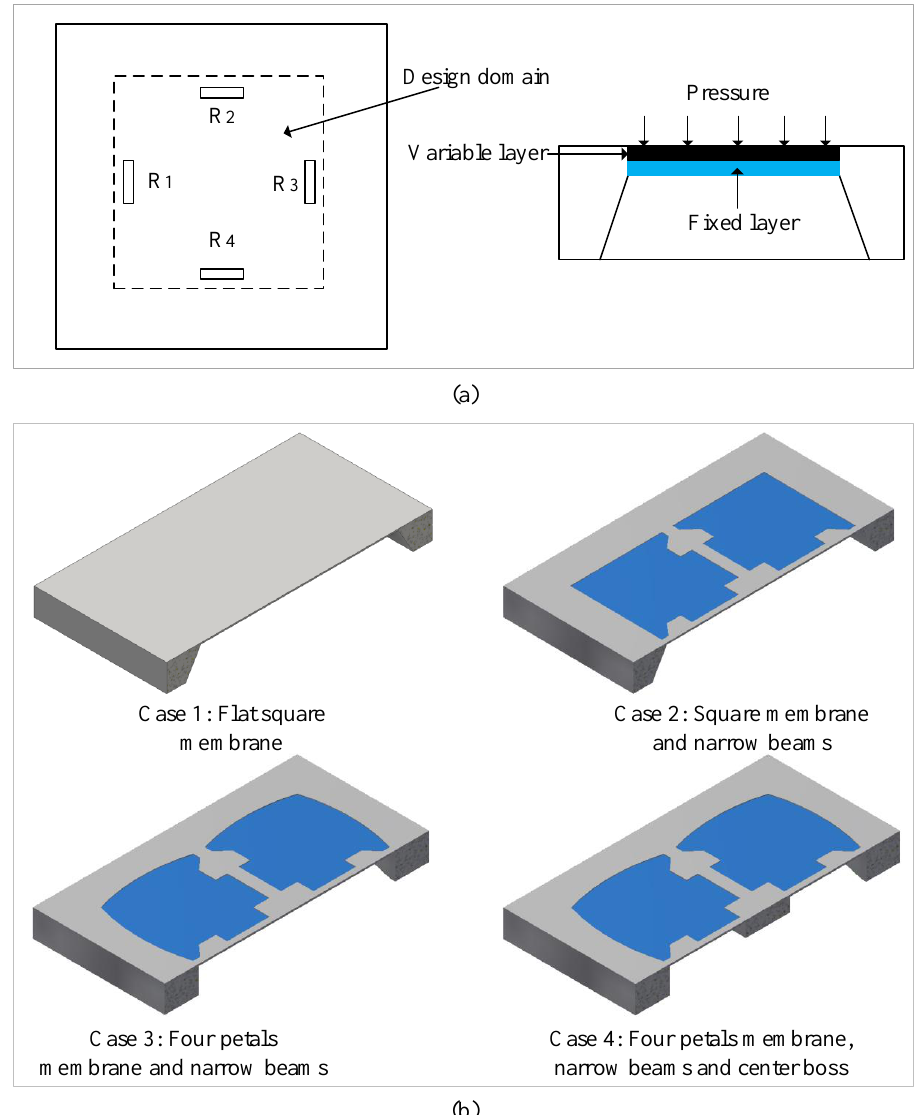
Figure 3. Design problem for the piezoresistive pressure sensor: ( a ) traditional flat diaphragm; ( b ) new design of the